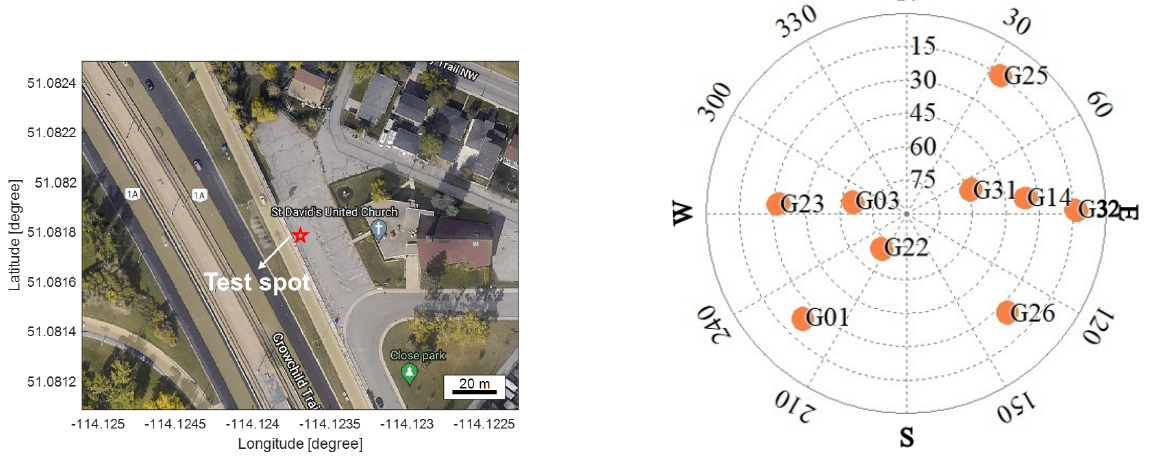
Figure 6. Open-sky test spot (Google Map show) and sky plot of available GPS